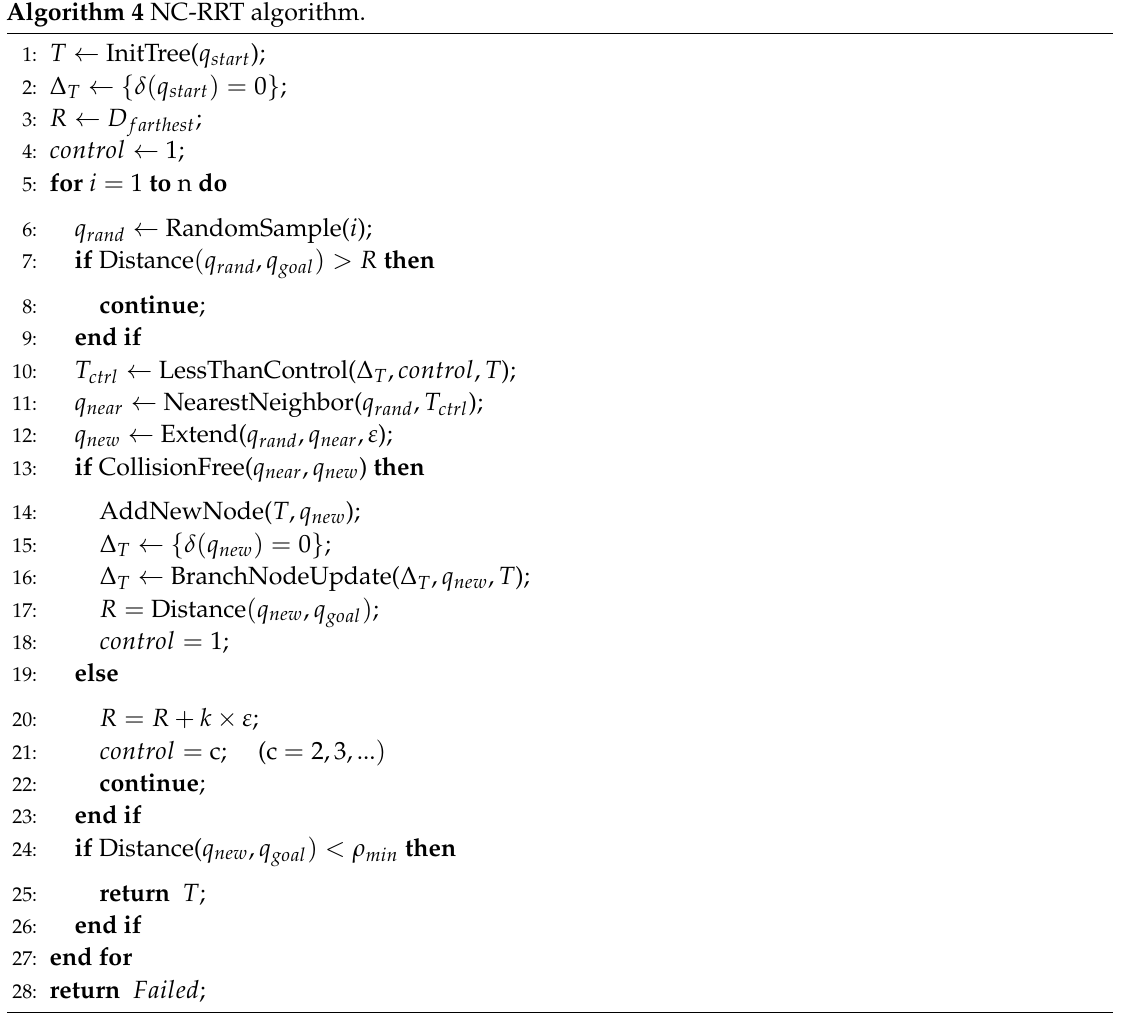
Algorithm 4 NC-RRT